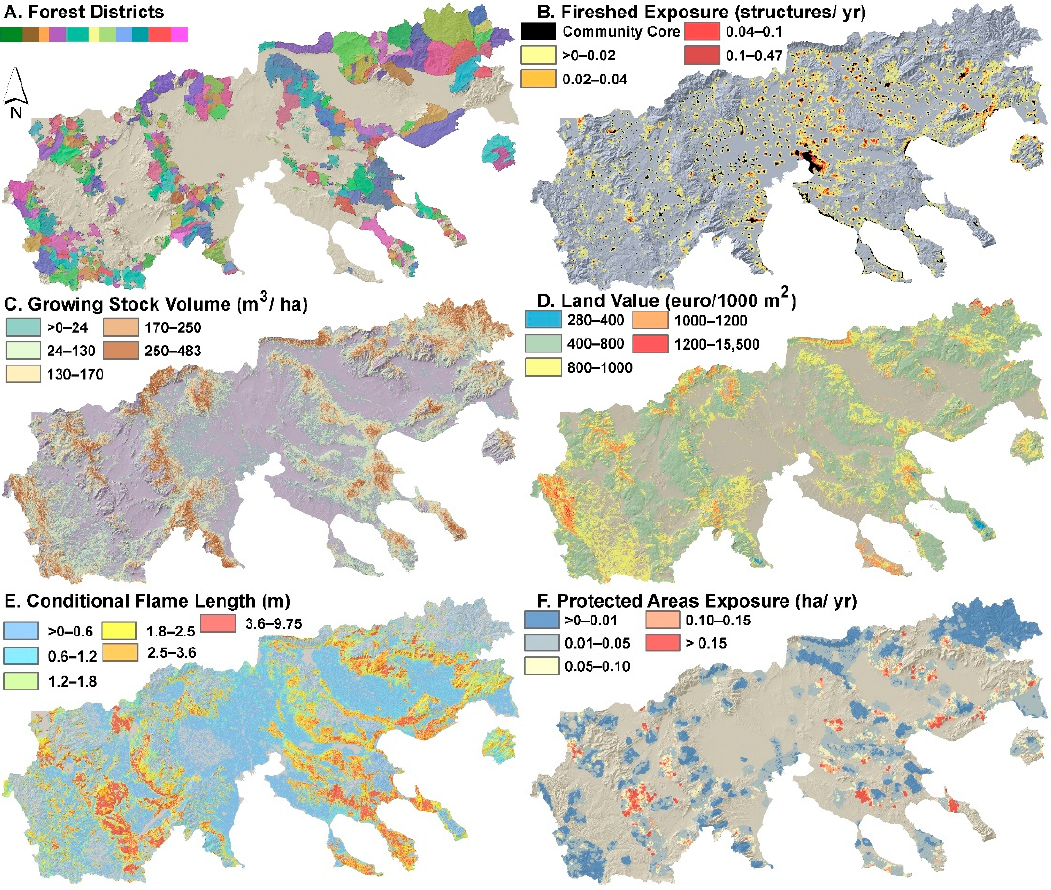
Figure 2. ( A ) The 290 forest districts with a forest management plan; The five metrics used to prioritize stands for treatment: ( B ) fireshed exposure of developed areas in annual structures affected as estimated by wildfire simulations; ( C ) per pixel average growing stock volume of all living trees >10 cm in diameter at breast height; ( D ) average land value per pixel in EUR per 1000 m 2 ; ( E ) conditional flame length; and ( F ) exposure of protected areas in values of annual area burned, as estimated by wildfire simulations.